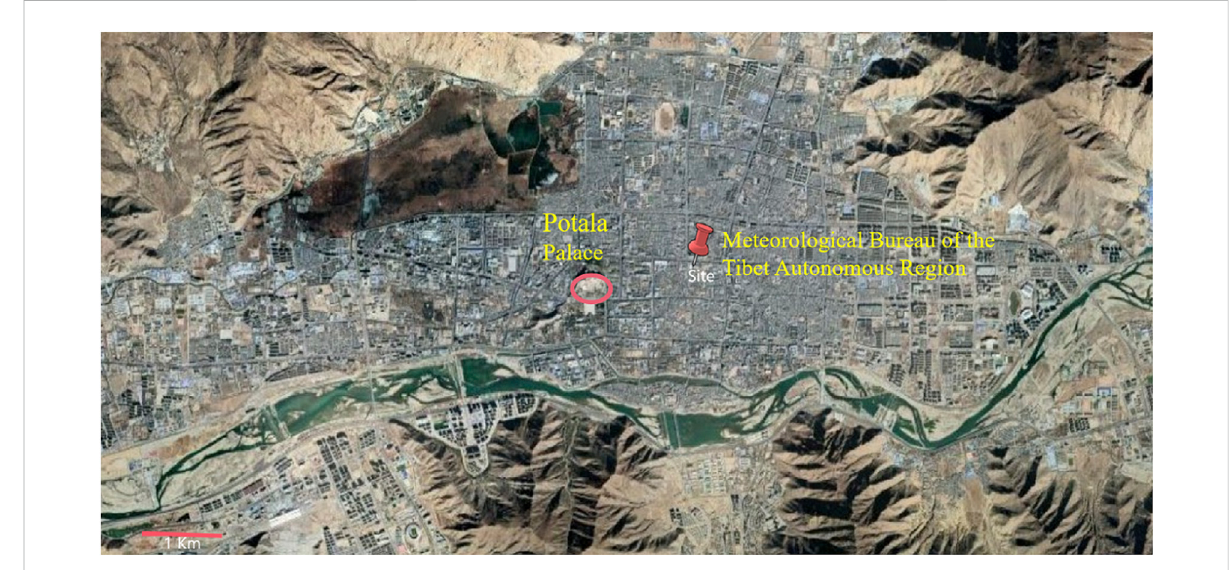
Measurement site ’ s location and nearby topography in Lhasa. Measurement was conducted in the central urban